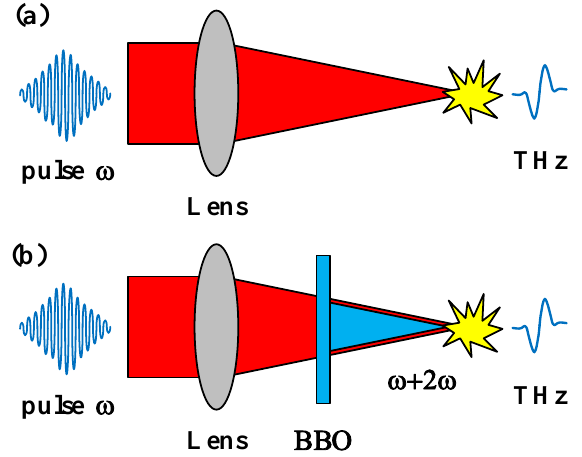
Figure 3. Schematic diagram of laser-induced plasma radiation terahertz wave. ( a ) single-color method; ( b ) two-color